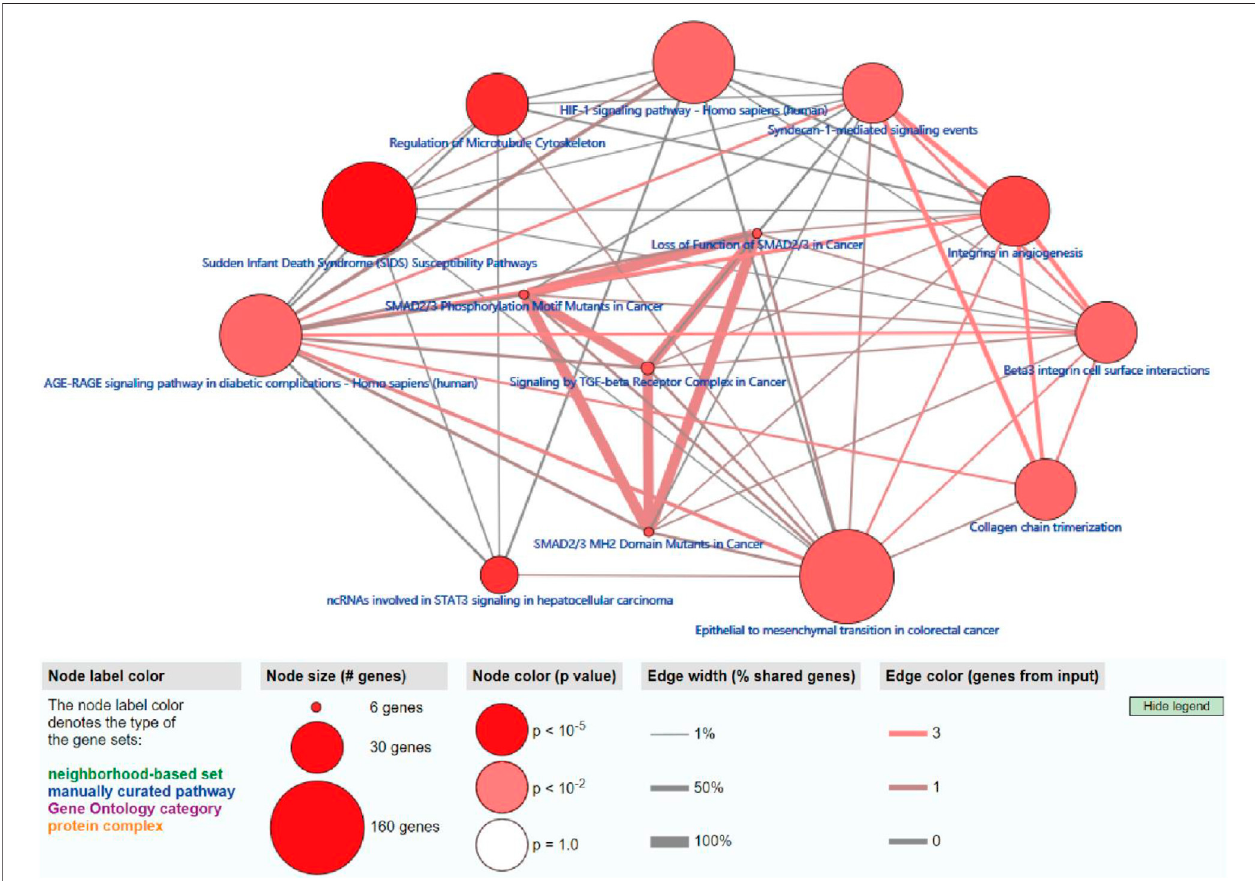
FIGURE 6 | ConsensusPathDB analysis indicating that differentially expressed mRNAs were most enriched in 14 pathways.